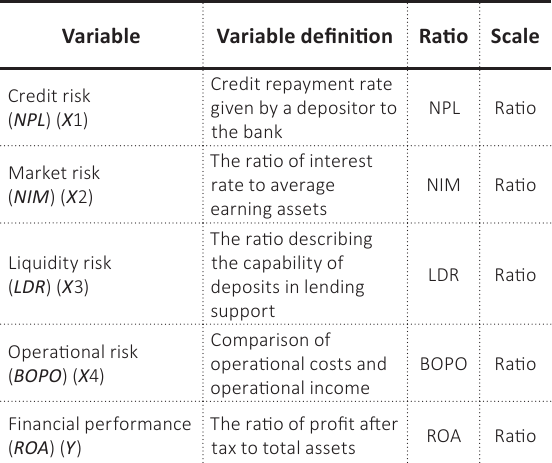
Table 1. Definition of operational